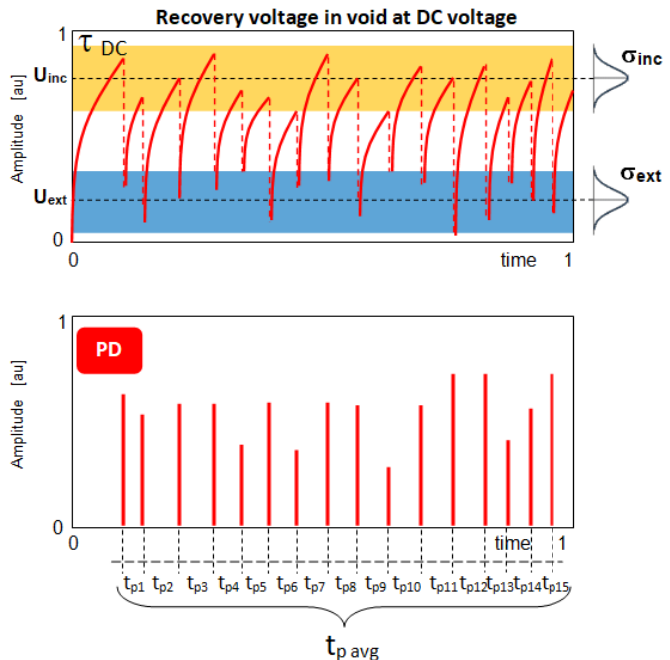
Figure 12. Variability of t p time in a stochastic PD model at DC voltage, variable inception U ci and extinction U ce voltage levels according to normal distribution with standard deviation σ inc and σ ext , respectively.